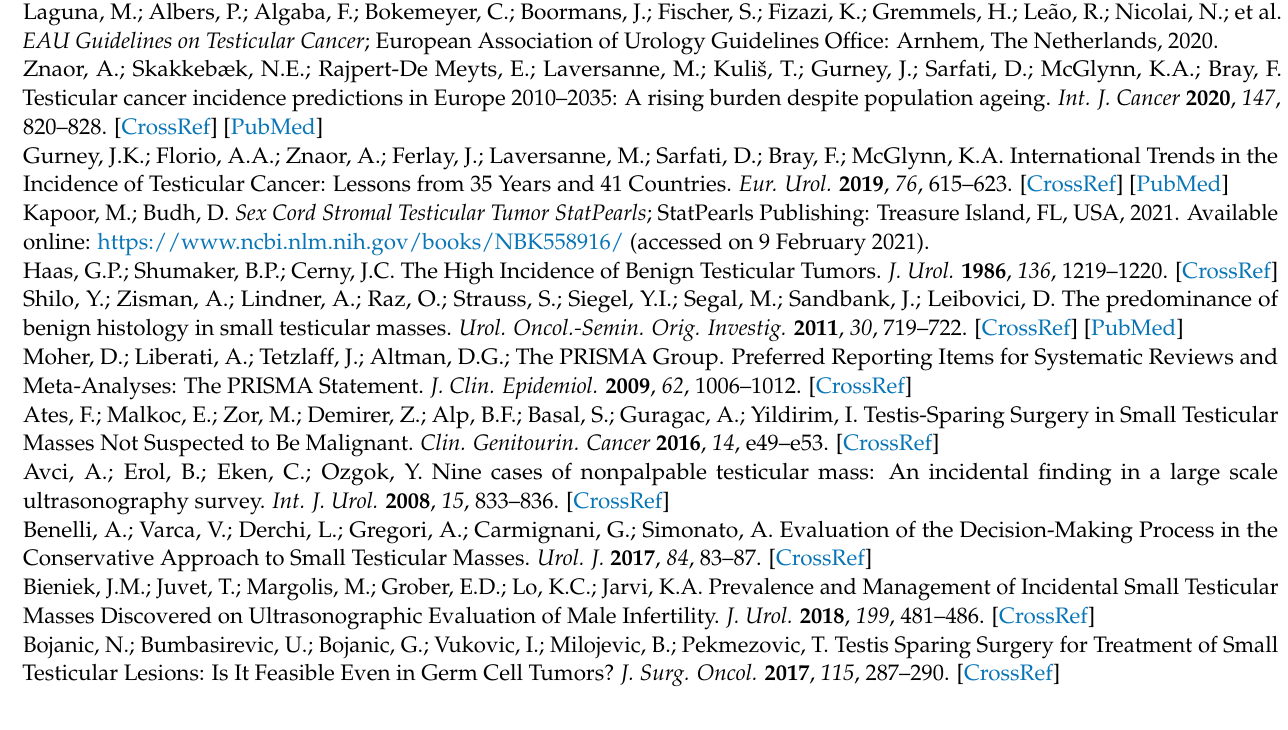
Table S1: List of articles included in this systematic